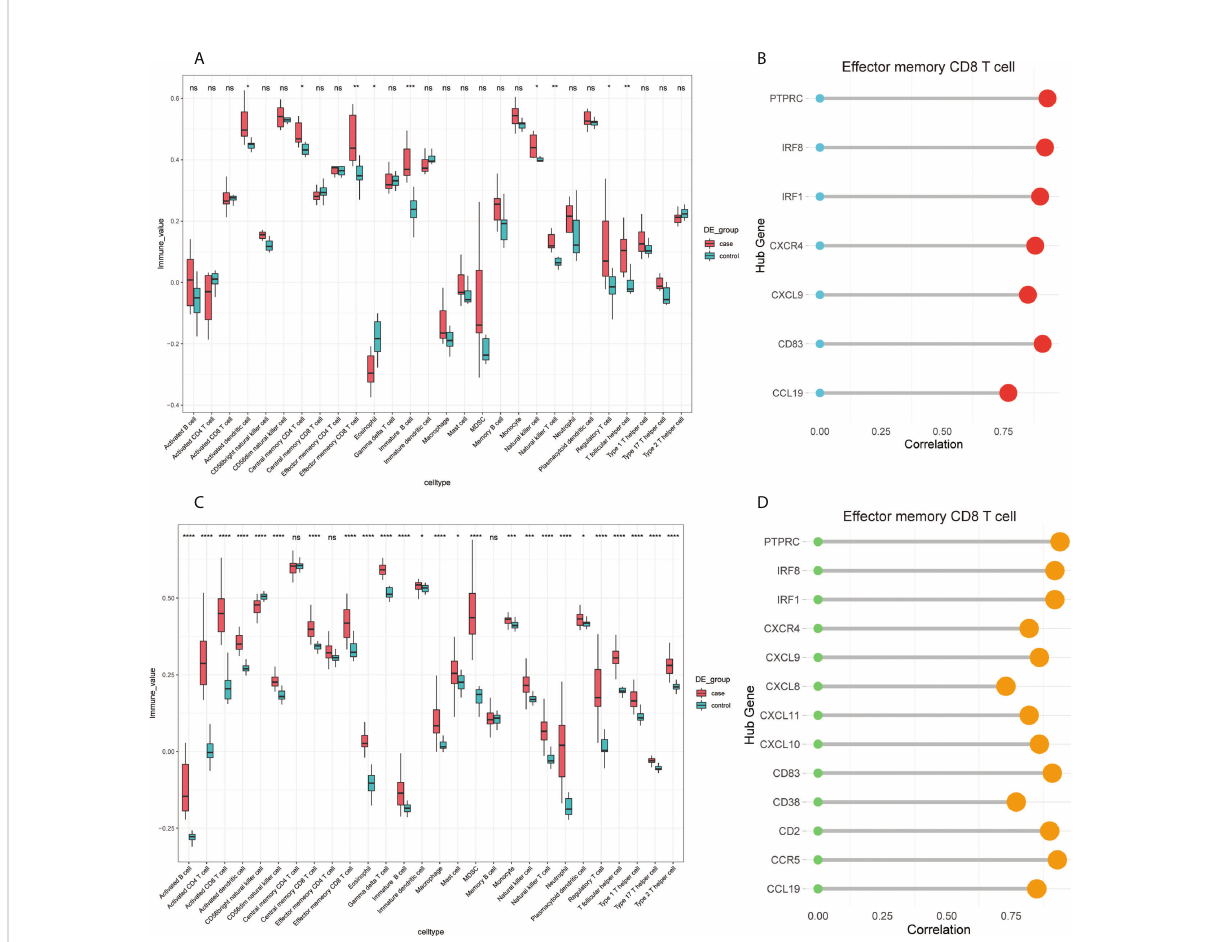
FIGURE 10 In fi ltrating immune cells by ssGSEA and the correlation of effector memory CD8+ T cell and hub genes: (A) fraction of in fi ltrated immune cells in GSE125733, *p < 0.05, **p < 0.01, ***p < 0.001, ****p < 0.0001; (B) correlation between the expression levels of hub genes and immune in fi ltration scores of effector memory CD8+ T cells in GSE125733, *p < 0.05, **p < 0.01, ***p < 0.001, ****p < 0.0001; (C) fraction of in fi ltrated immune cells in GSE65914; and (D) correlation between the expression levels of hub genes and immune in fi ltration scores of effector memory CD8+ T cells in GSE65914. ns, no signi fi